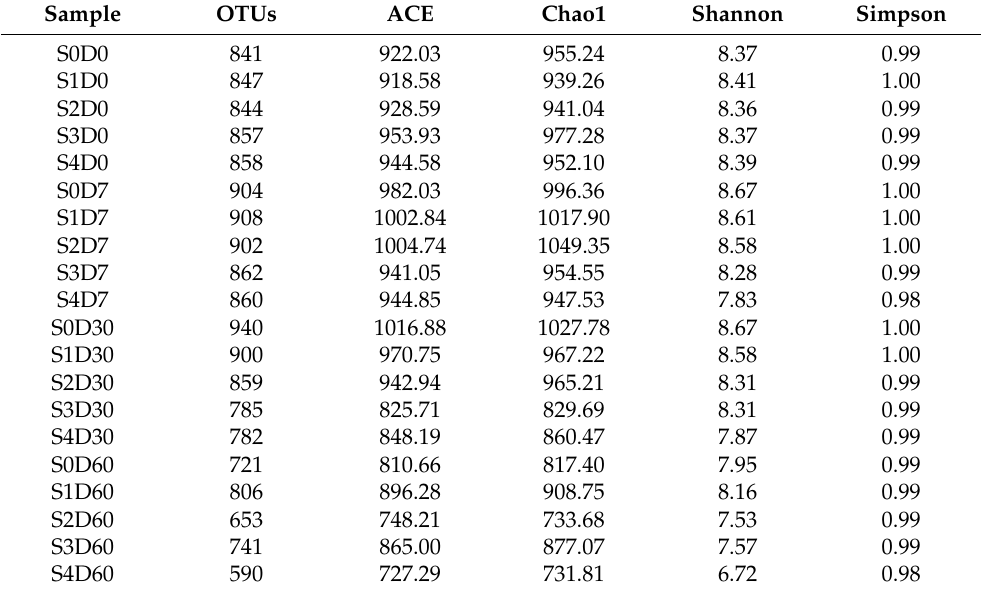
Table 2. Alpha diversity index of bacteria in